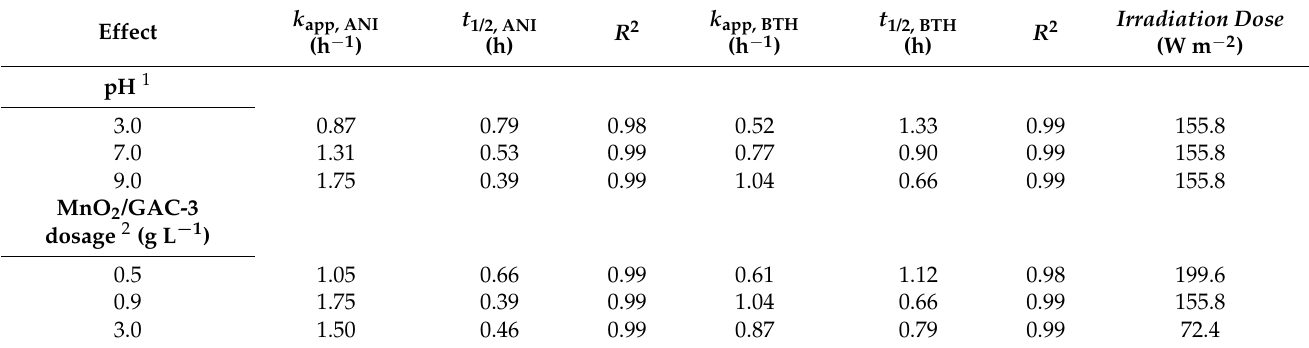
Table 5. Summary of the kinetic parameters and coefficients of determination ( R 2 ) of the photocatalytic process using MnO 2 /GAC-3 composites after reaction for 1